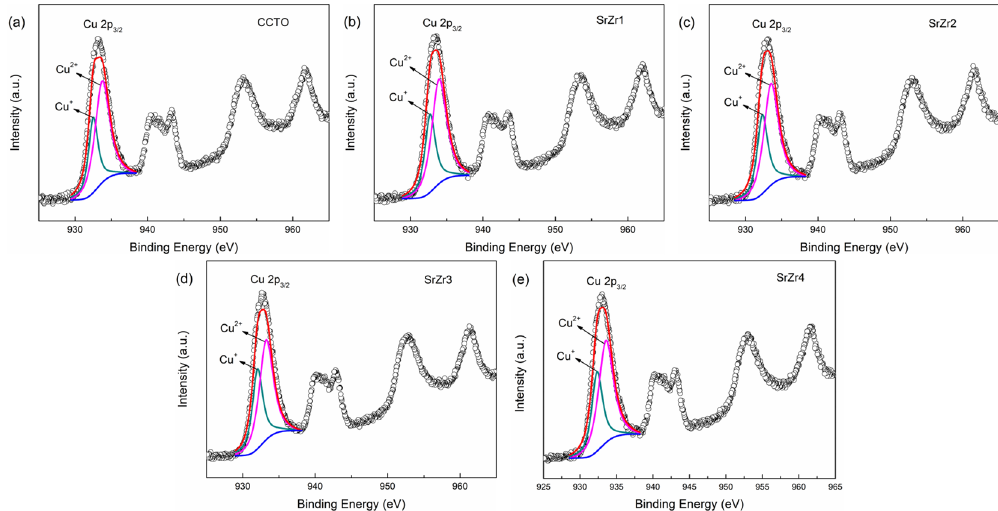
Figure 3. XPS Cu 2p spectra obtained for the as-prepared ceramics: ( a ) CCTO; ( b ) SrZr1; ( c ) SrZr2; ( d ) SrZr3; ( e ) SrZr4.